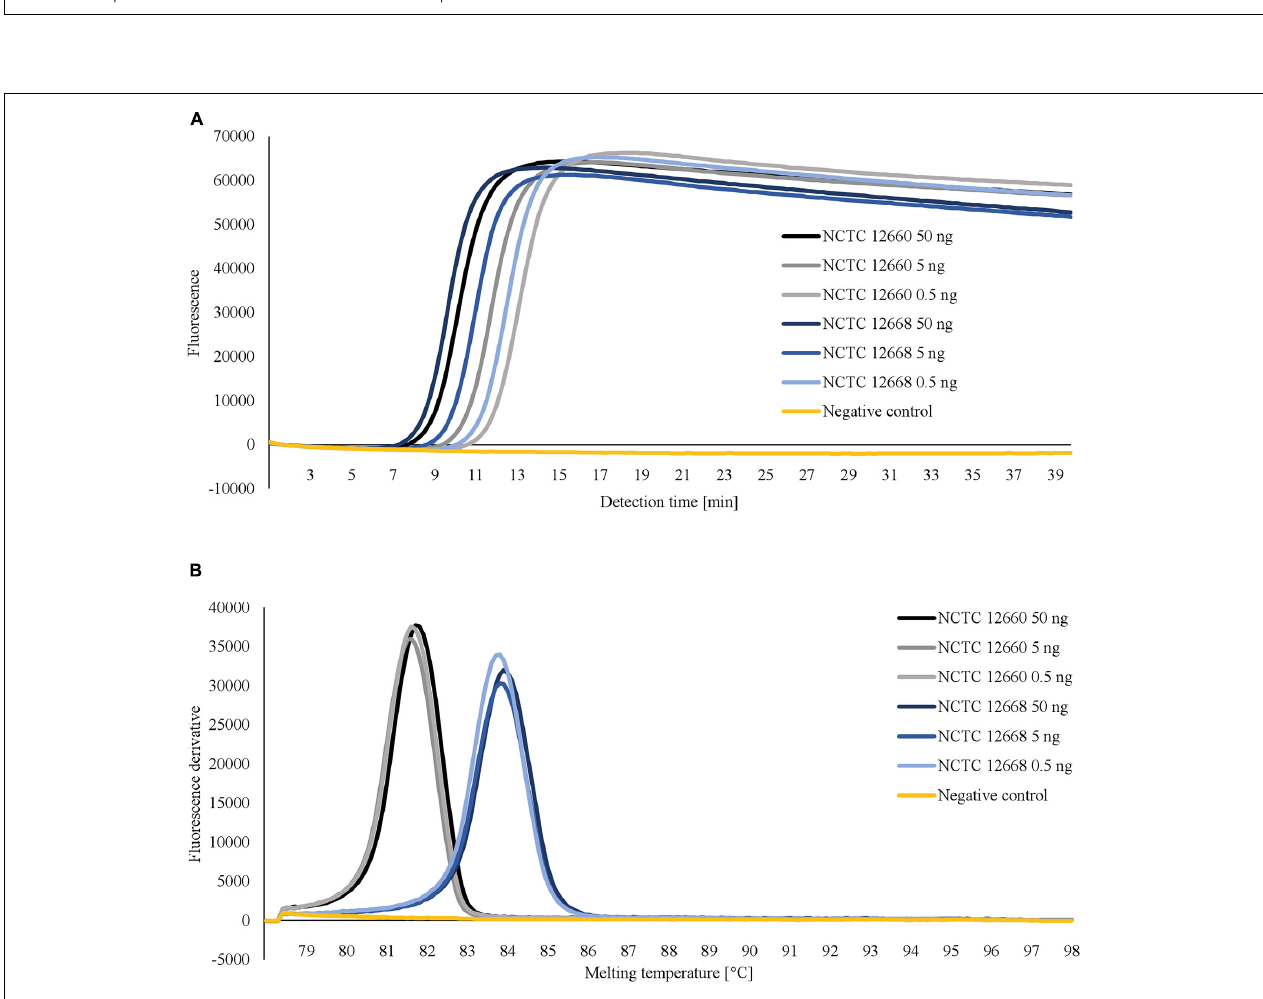
FIGURE 3 | Amplification curves (A) and corresponding melting curves of LAMP products (B) obtained after testing 10-fold serially diluted DNA templates of C. jejuni NCTC 12660 and C. coli NCTC 12668 with merged cdtC – gyrA primers. For a better overview, only the first three dilution levels are shown. Pure cultures of C. jejuni und C. coli were distinguishable in one reaction by different melting temperatures of their LAMP